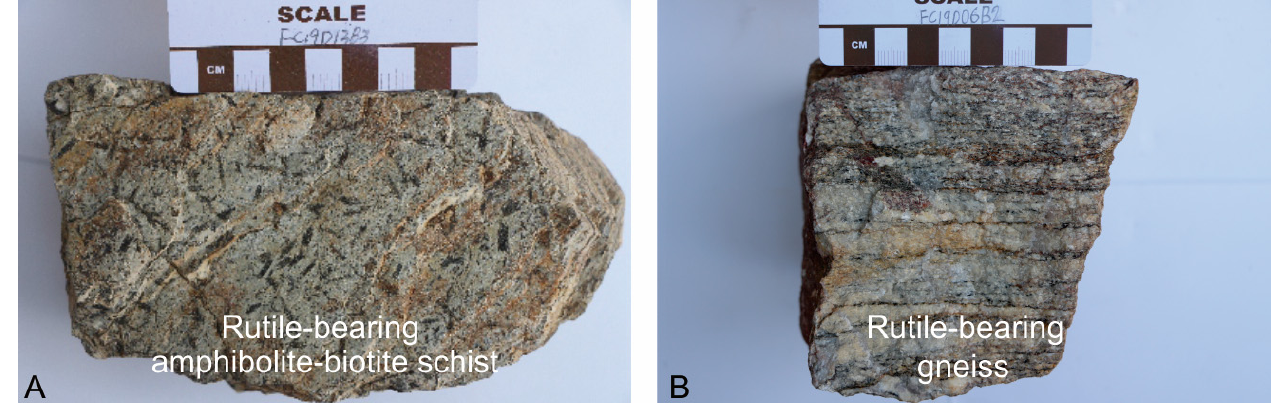
Figure 2. Hand specimen photographs at the Bamiao–Qingshan district. ( A ) Rutile-bearing amphibole-biotite schist; ( B ) rutile-bearing gneiss.